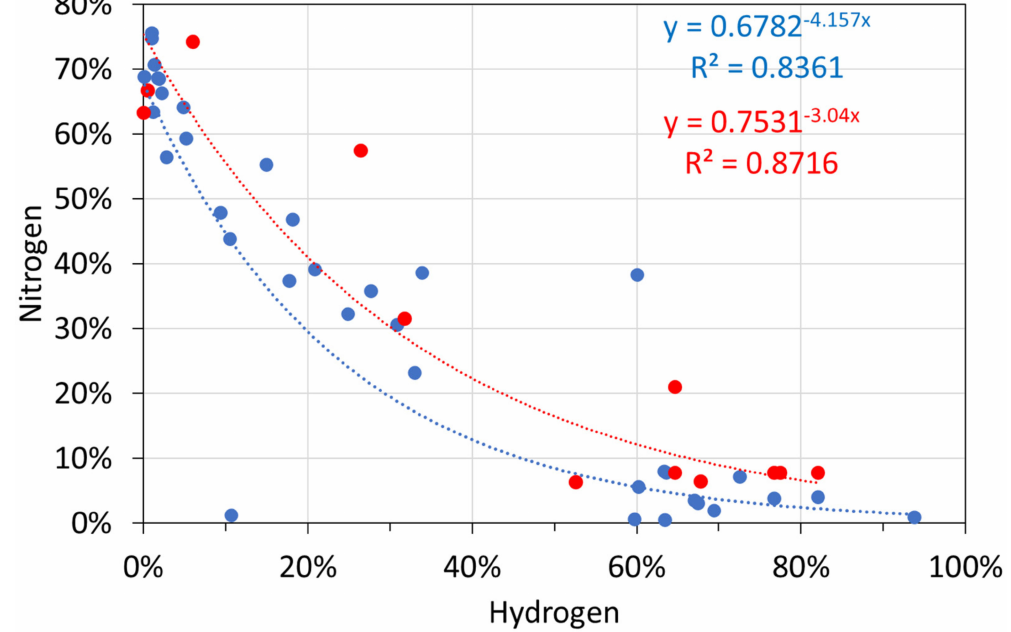
Figure A4. Molar gas analyses: hydrogen vs. nitrogen. Blue circles: T ≤ 298 K; red circles: T = 348